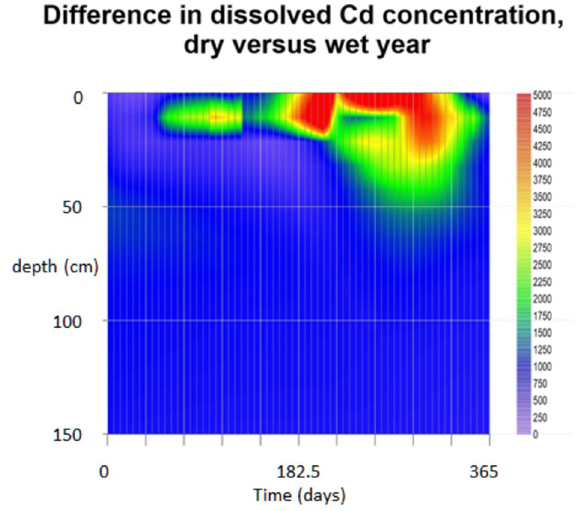
Fig. 9 Difference in dissolved cadmium content (fraction) in a dry versus a wet year during a period of 365 days. Time (in days) on the x-axis, the soil depth (in cm) on the